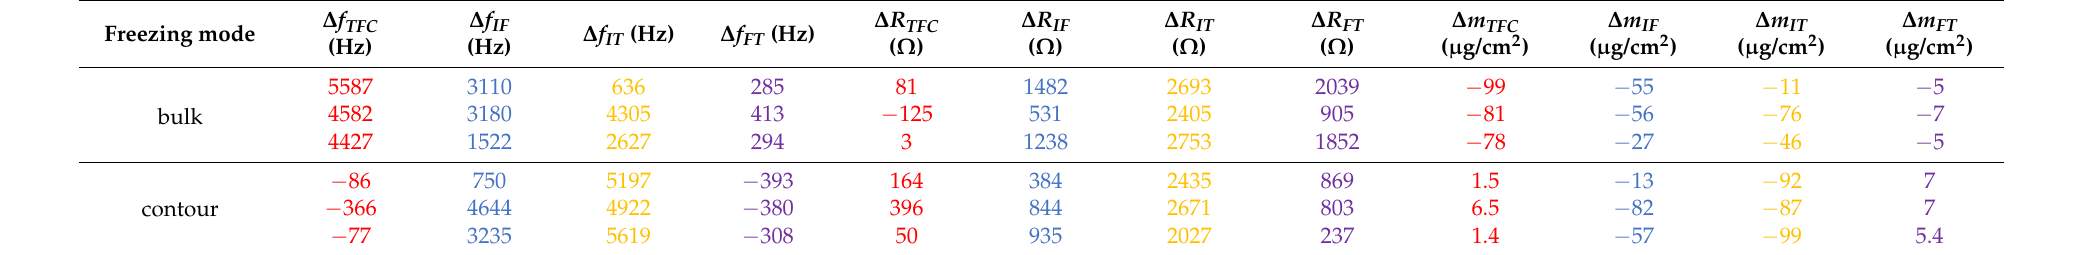
Table 1. Raw data extracted from the automatically saved numerical data sheets. ∆ f TFC ; ∆ R TFC ; ∆ m TFC denote the temperature-induced resonance frequency, series resistance and mass displacement shifts, respectively. ∆ f IF ; ∆ R IF ; ∆ m IF represent the resonance frequency, series resistance and mass displacement shifts upon initial droplet freezing (i.e., recalescent freezing). ∆ f ∆ R ∆ m IT ; IT ; IT indicate the resonance frequency, series resistance and mass displacement shifts upon initial droplet thawing. resistance and mass displacement shifts upon complete droplet thawing.